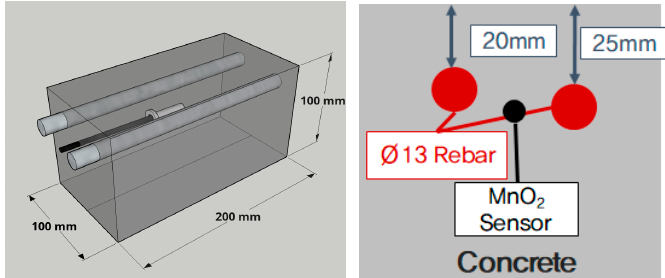
Figure 2. Schematic diagram of specimen for monitoring corrosion potential test.